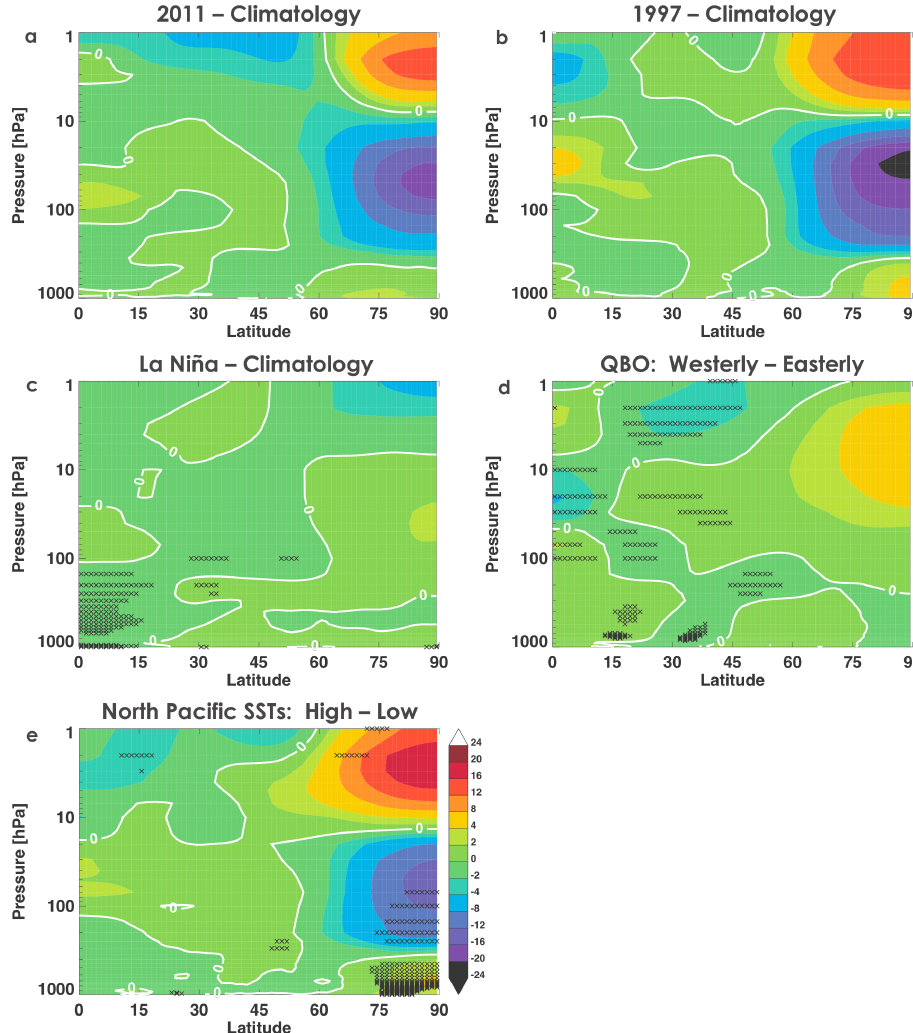
Figure 3 432 Fig. 3. March temperature differences [K]: (a) 2011 from the 1979–2011 climatological mean (i.e., blue contours indicate regions where March 2011 is cooler than the climatology); (b) 1997 from the climatological mean; (c) composite of La Ni˜na events from the climatological mean; (d) QBO-westerly years – QBO-easterly years; (e) strongly positive subarctic SST years – strongly negative subarctic SST years (further discussed in the text). In (c) , (d) and (e) black Xs denote differences significant at the 95% confidence level. Zero difference contours are shown in